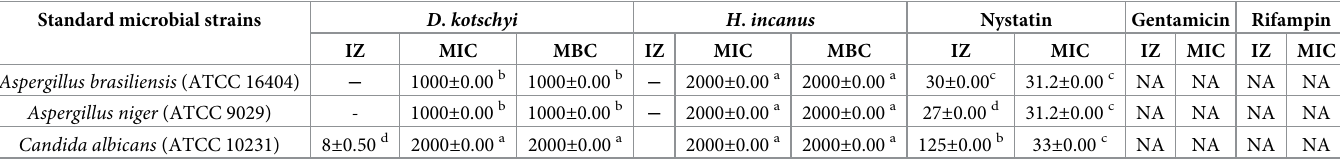
IZ: The diameters of growth inhibition zone includes the diameters of disks (6 mm); ND: not determined; NA: no activity; Values with different letters are statistically different (Duncan, p �